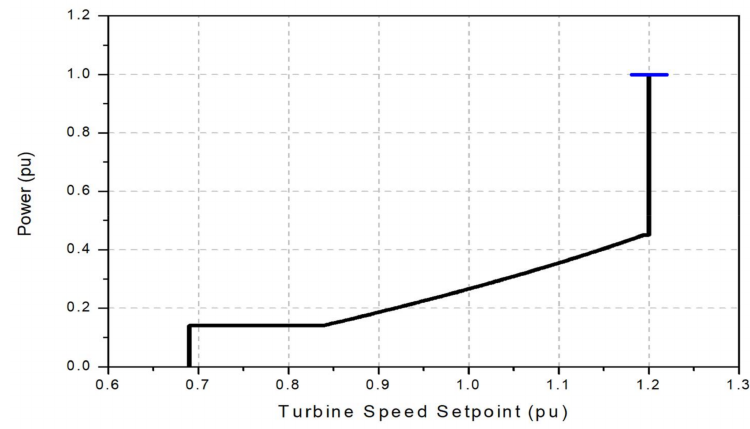
Figure 17. Relationship between the rotor speed set point and the output power of the GE 1.5 MW DFIG